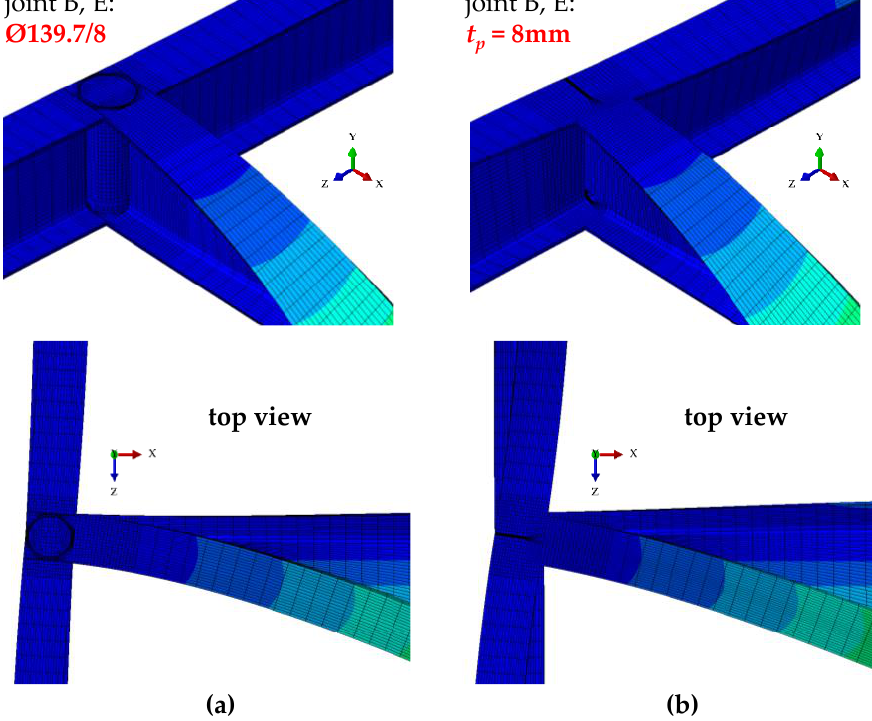
Figure 8. Bimoment deformations of B joint of H-grillage obtained with Abaqus: ( a ) closed-section stiffener Ø139.7/8, ( b ) flat stiffener t p = 8 mm.